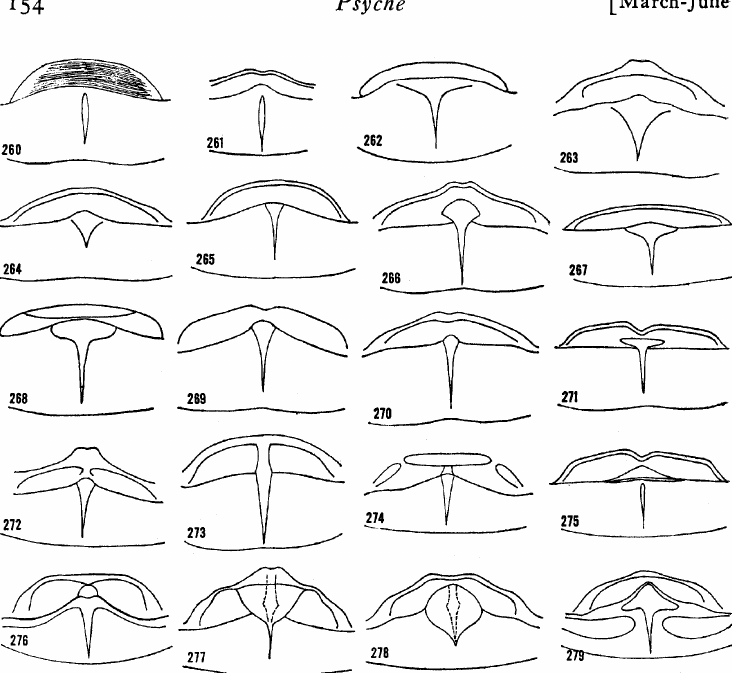
Figures 260-279. Schematic outlines (not drawn to scale) of ridges found on the first abdominal tergites of Calolamra males. 260. C.